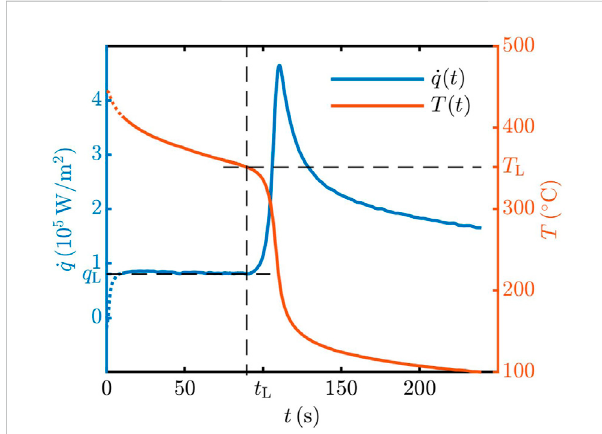
FIGURE 4 Temperature and heat fl ux at the spray and target axis at the wall surface as a function of time for spray cooling by distilled water. Initial substrate temperature was T w0 = 445 ° C.